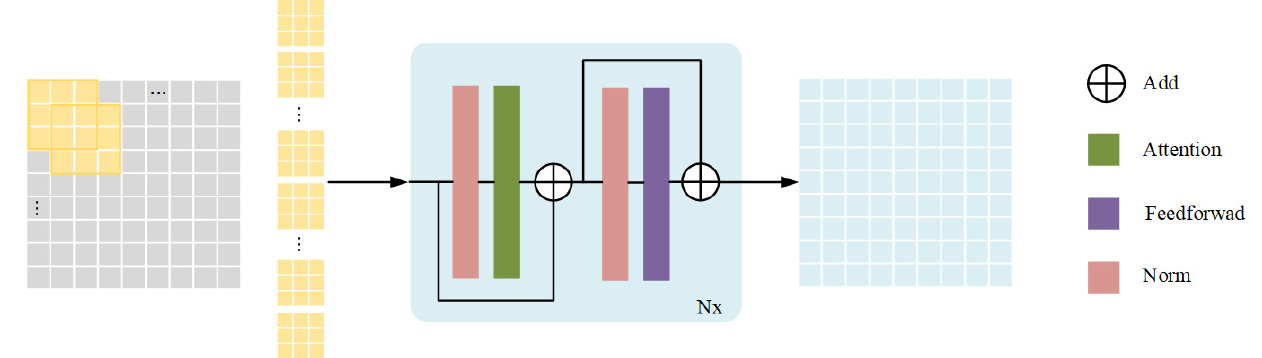
Figure 2. Structure of improved transformer encoder (ITE).